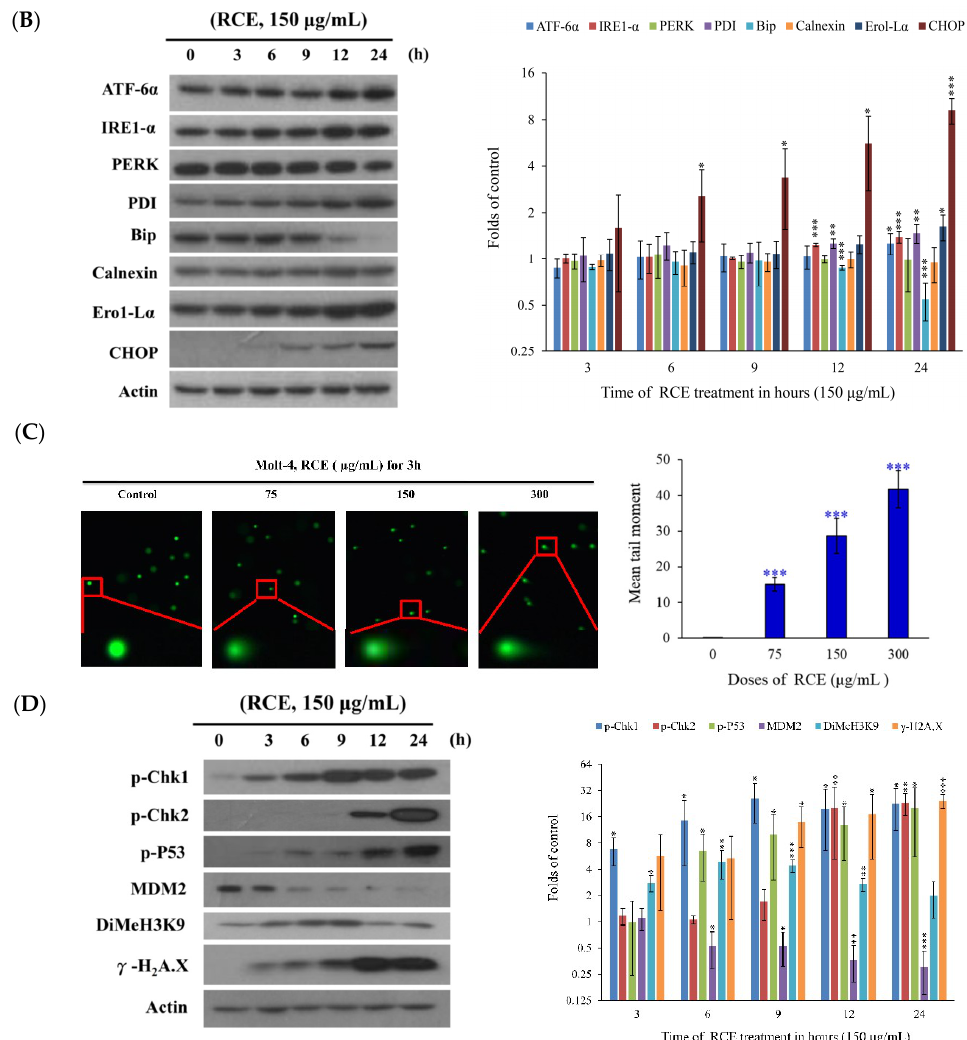
Figure 4. E ff ect of RCE on the induction of ER stress and DNA damage in Molt-4 cells. ( A ) Cells were treated with RCE (150 µ g / mL) for the indicated times. Quantitative results showed a gradual increase in calcium accumulation in response to RCE treatment when compared with the control group; ( B ) The e ff ect of RCE on the expression of ER stress-related proteins of Molt-4 cells was examined with Western blotting assay. The target protein was compared with the respective actin and then compared with the control group. The blots were quantified using the Odyssey image analysis system with ImageJ software. Cells were treated with 150 µ g / mL RCE for the indicated times; ( C ) An example of the “comet tail” due to chromosomal DNA double-strand breaks in RCE-treated Molt-4 cells (0, 37.5, 75, and 150 µ g / mL) compared with the untreated control. Electrophoresis was carried out under neutral conditions. Quantitative results showed a gradual increase in the tail movement upon RCE treatment when compared with the control. Results are presented as mean ± SD of three independent experiments (*** p < 0.001) (400 × ); ( D ) Cells were harvested, and the lysates were prepared and subjected to SDS-PAGE followed by immunoblotting of DNA damage-related proteins. Actin was used as the loading control in B and